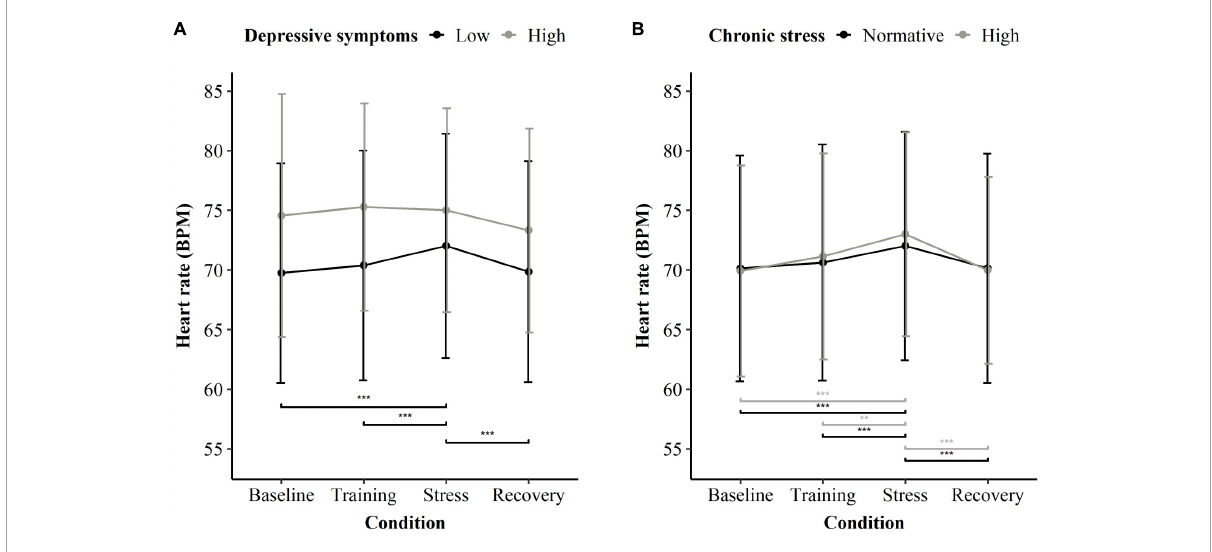
FIGURE2 Heart rate averaged per condition of the stress exposure (MIST) and stress/depression subgroup. (A) Mean heart rate for participants low in depressive symptoms (black), n = 180, and high in depressive symptoms (gray), n = 14. All participants, regardless of their chronic stress level, were considered. (B) Mean heart rate for participants with normative chronic stress (black), n = 152, and high chronic stress (gray), n = 42. All participants, regardless of their depressive symptoms, were considered. Significant differences are indicated in a pairwise manner between baseline, stress, recovery, and within subgroups. ** p < 0.01 and *** p <